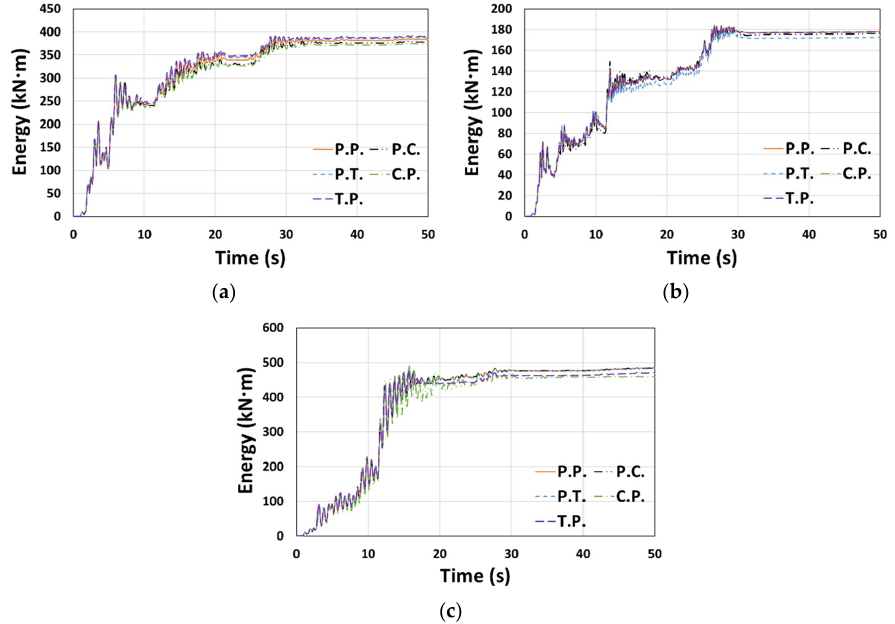
Figure 7. Cumulative dissipated energy: ( a ) Type 1 (El Centro, X-dir.), ( b ) Type 2 (El Centro, Y-dir.), and ( c ) Type 3 (El Centro, Y-dir.).